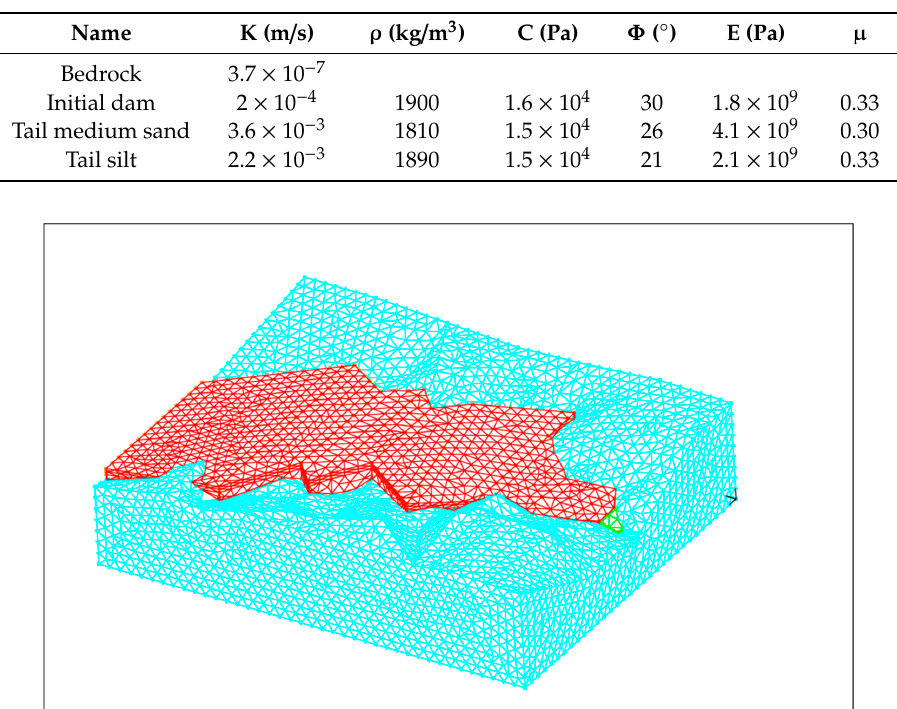
Figure 7. The model after grid generation.